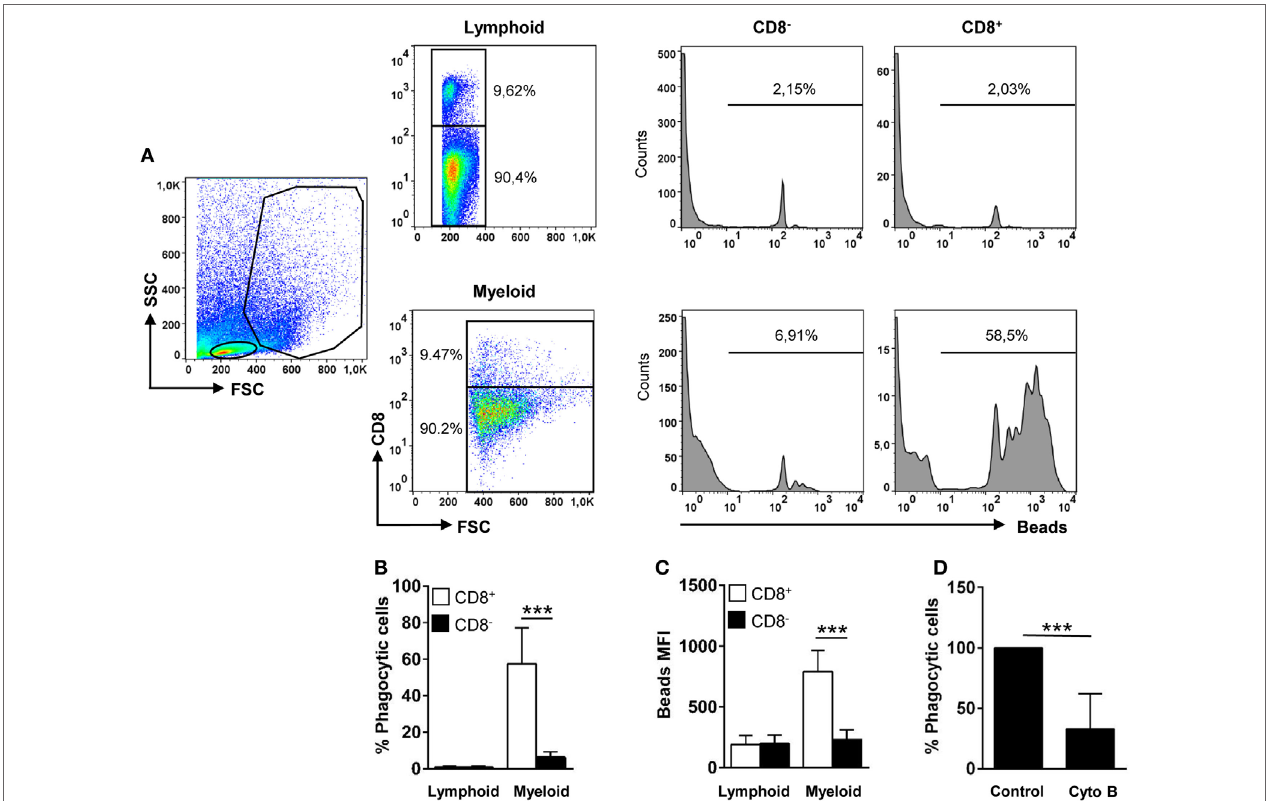
FigUre 2 | Phagocytic capacity of gills CD8 + dendritic cells (DCs). Leukocytes from gills were incubated with Crimson Red fluorescent polystyrene beads (1 µm diameter) at a ratio of 1:10 (cell/beads) for 16 h. Non-ingested beads were removed in a glucose gradient, and the cells were stained with anti-CD8 α and analyzed by flow cytometry (a) . Lymphoid cells (upper panels) and myeloid cells (lower panels) were gated, and CD8 − and CD8 + cells were further selected to analyze and measure the fluorescence of internalized beads (histograms). The percentage of cells containing beads was determined using control samples without beads to establish the phagocytosis gate shown in the histograms. The average percentage of phagocytic CD8 − and CD8 + cells (B) and the mean fluorescence intensity (MFI) of the internalized beads (c) were used to determine the phagocytic capacity of each cell type. Data are representative of 11 individual fish from 5 different experiments. (D) Cytochalasin (0.05 µg/ml) was added to the cells immediately before the addition of the beads to demonstrate active phagocytosis. Results are shown as the percentage of phagocytic gill CD8 + DCs relative to that of untreated controls (five individual fish) (*** p ≤